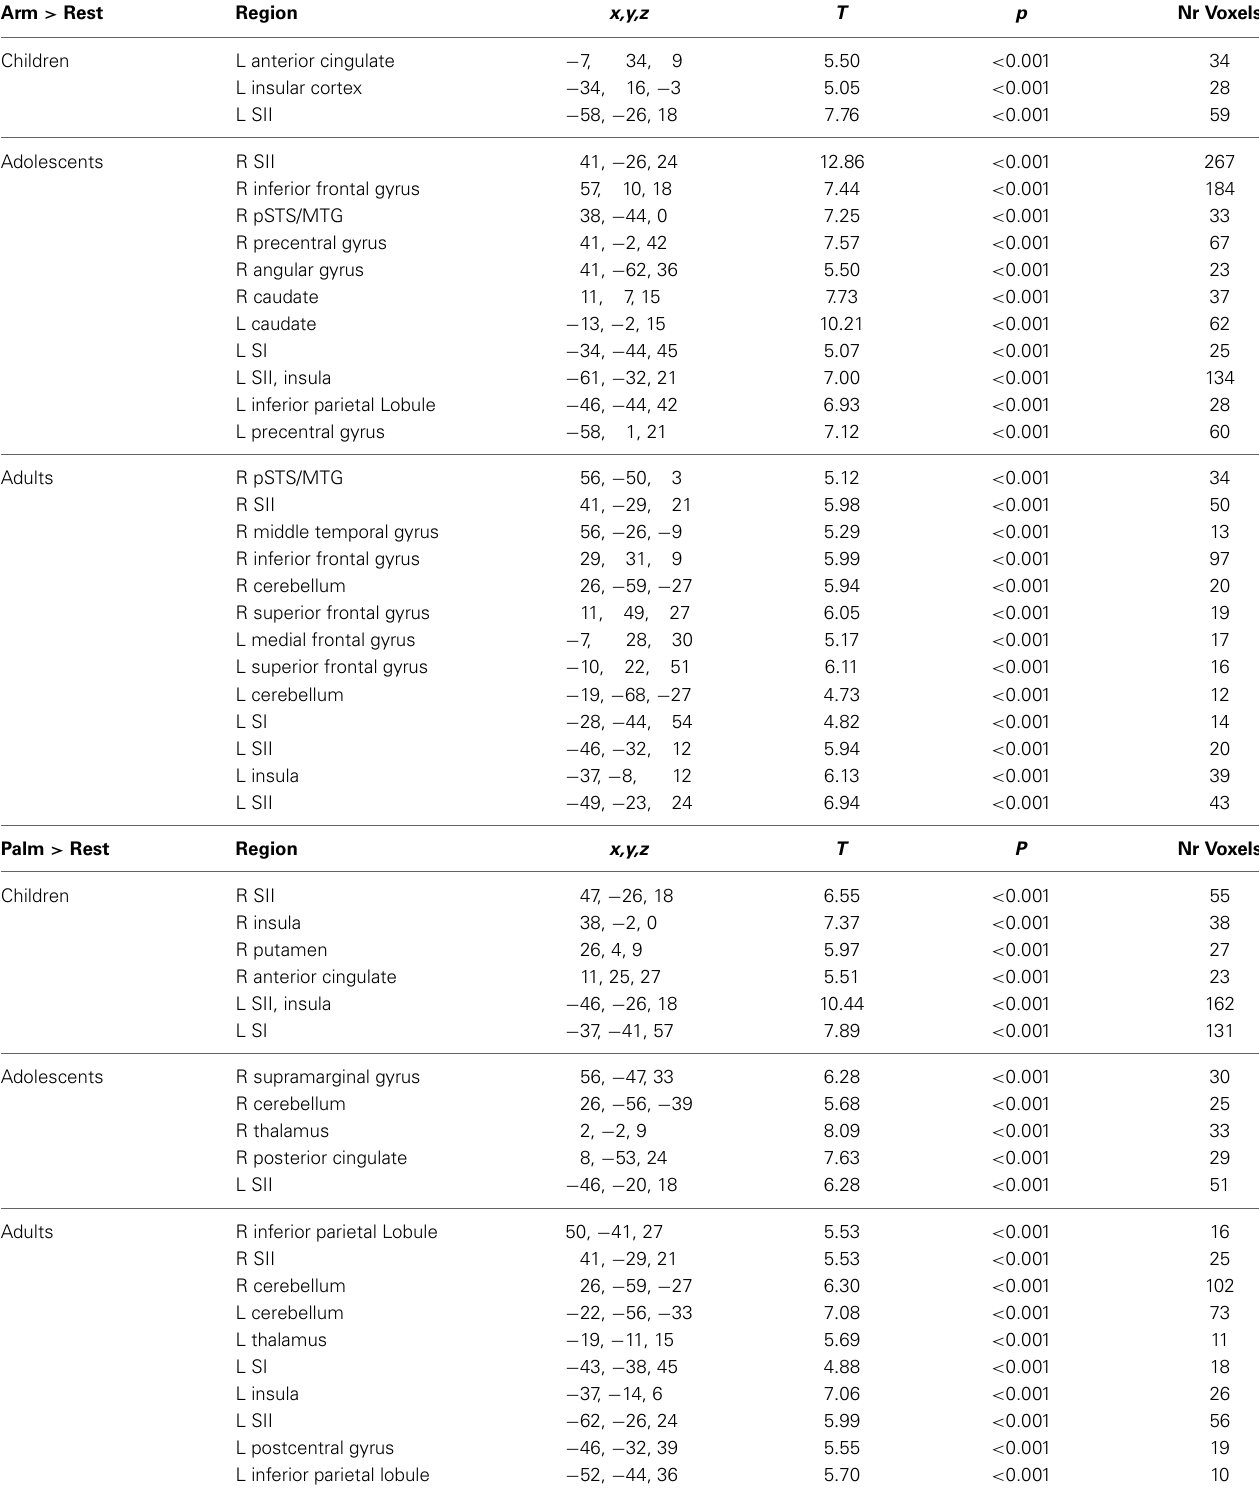
Table 1 | Brain regions showing significant activations in response to touch. Arm >